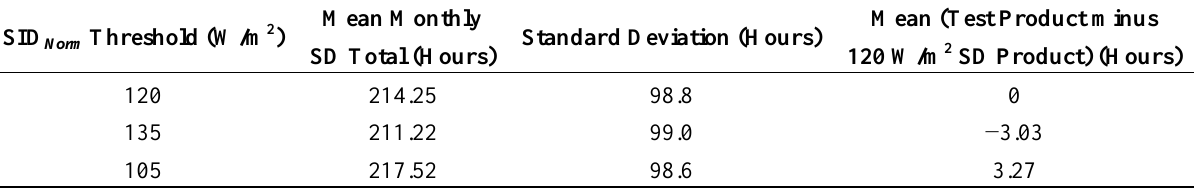
Table 2. Mean, standard deviation, and mean difference relative to the 120 W/m 2 SD product, for the SD-SID product with three different thresholds. The results correspond to monthly totals from 2008.